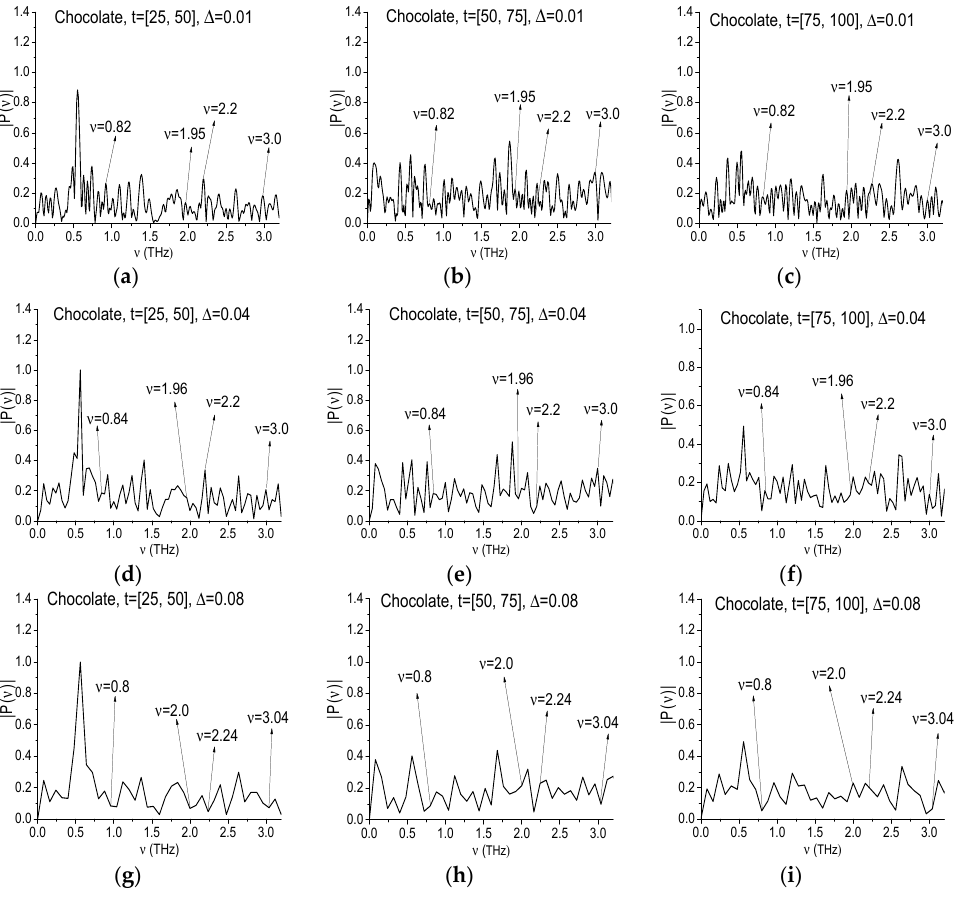
Figure 18. Signal Chocolate spectrum calculated in the time intervals t = [25, 50] ( a , d ), [50, 75] ( b , e ), [75, 100] ( c , f ) with the spectral resolution Δ ν = 0.01 THz ( a – c ), 0.04 THz ( d – f ), 0.08 THz ( g – i ).